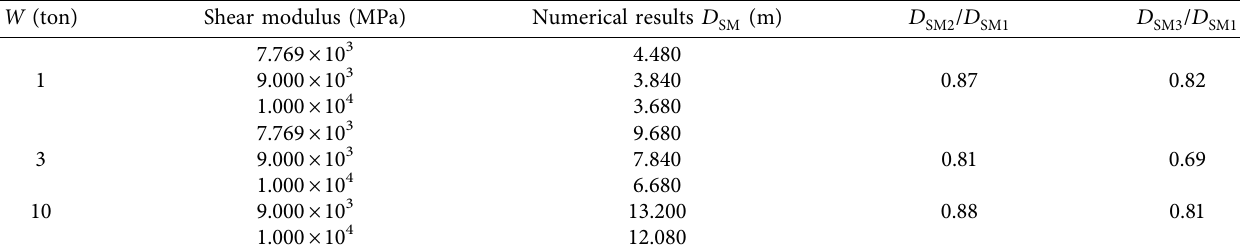
Table 8: Crater dimensions according to the shear modulus.